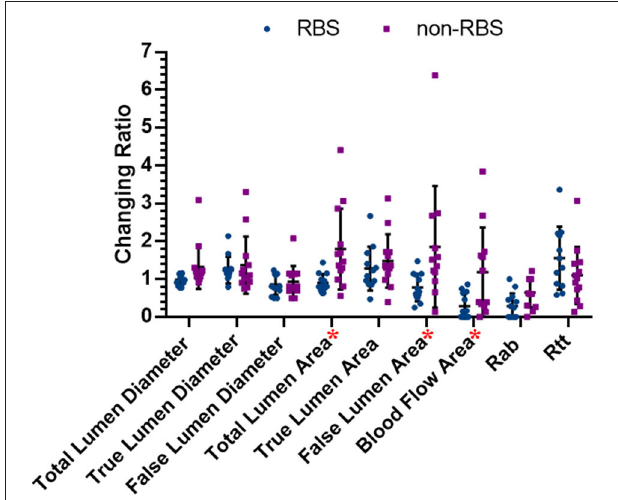
FIGURE 5 | Changing ratios in both RBS and non-RBS groups. Changing ratio: the latest data/preoperative data; * represents there is significant difference between two groups ( p < 0.05).